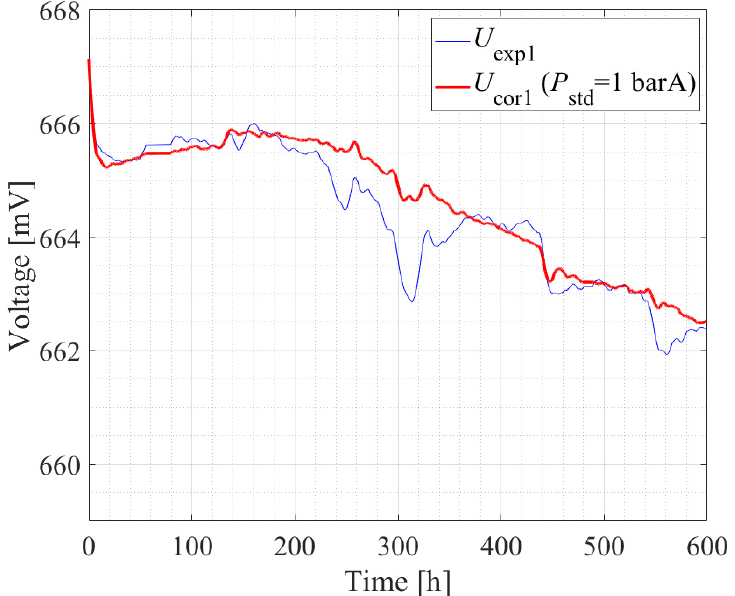
Figure 10. Application of the readjustment methodology for the pressure to the voltage from Figure 1. The corrected voltage U Cor1 is given at a standard pressure of 1 barA.